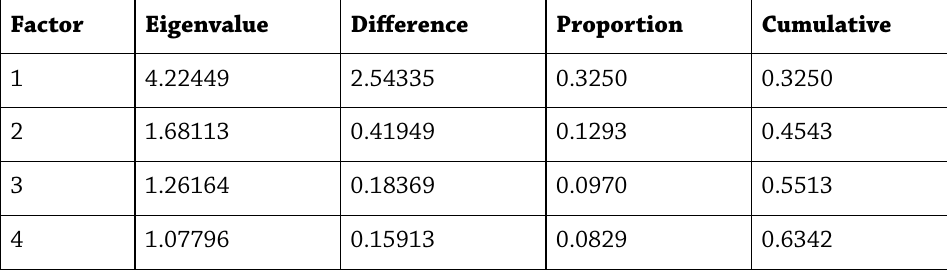
Table 4: The Extraction Step of Factor Analysis Factor